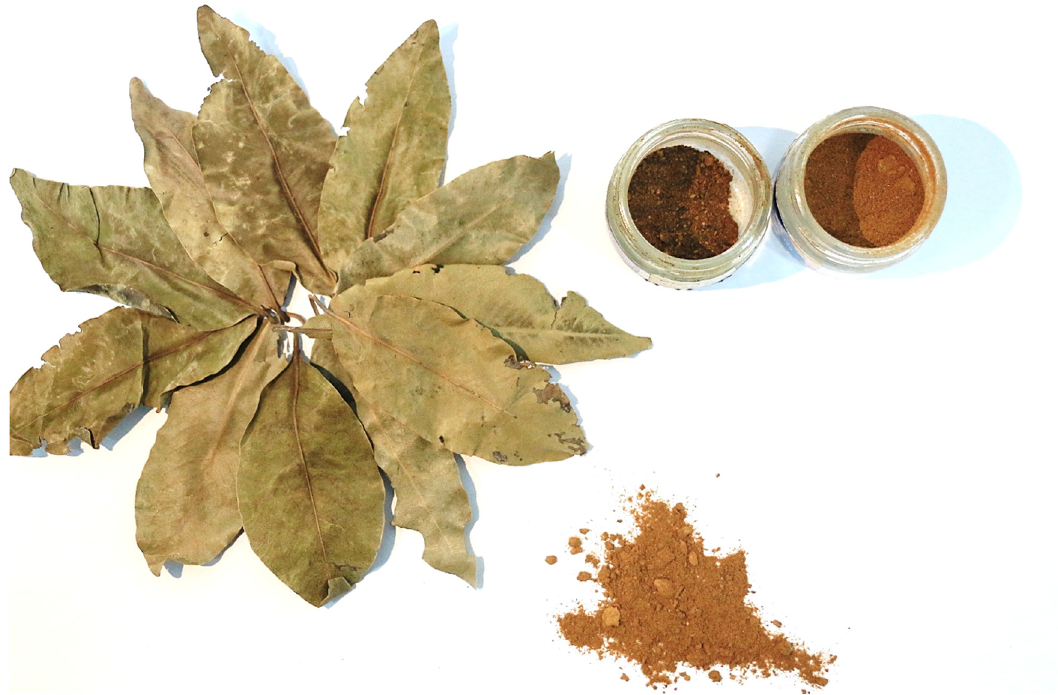
Figure 4: Appearance of Annona muricata extract along with the